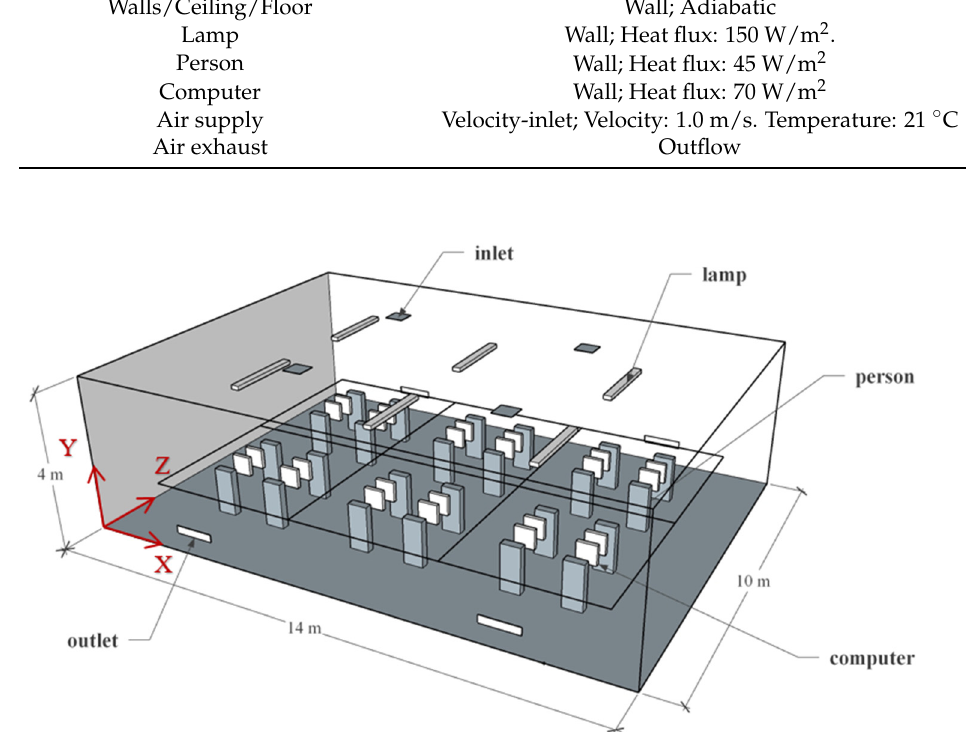
Figure 4. A model for the office.